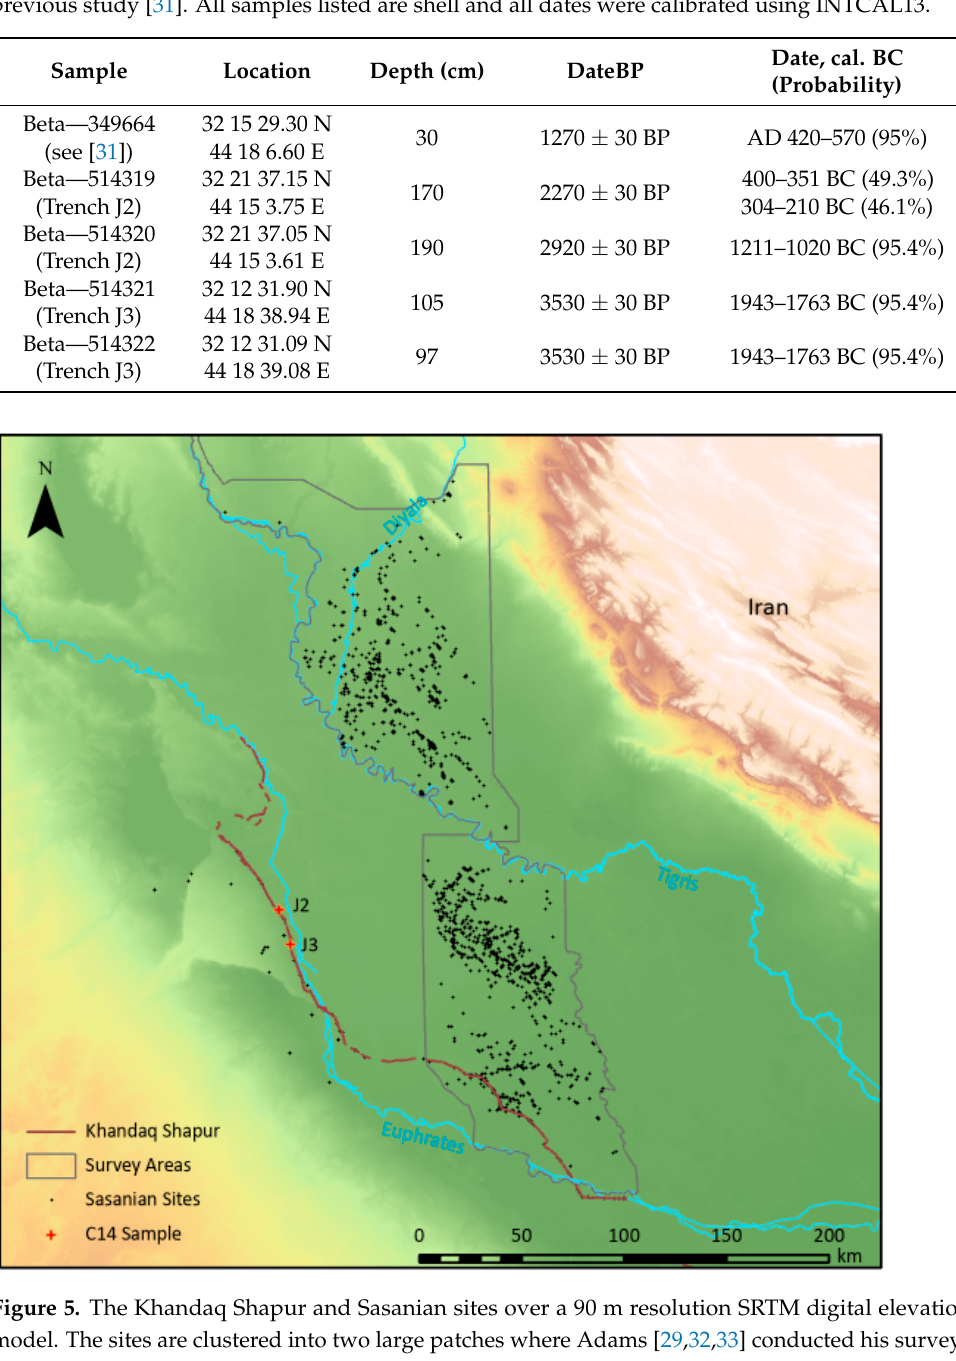
Table 1. All radiocarbon dates from the Khandaq Shapur, including one (Beta—349664) from a previous study [31]. All samples listed are shell and all dates were calibrated using INTCAL13.